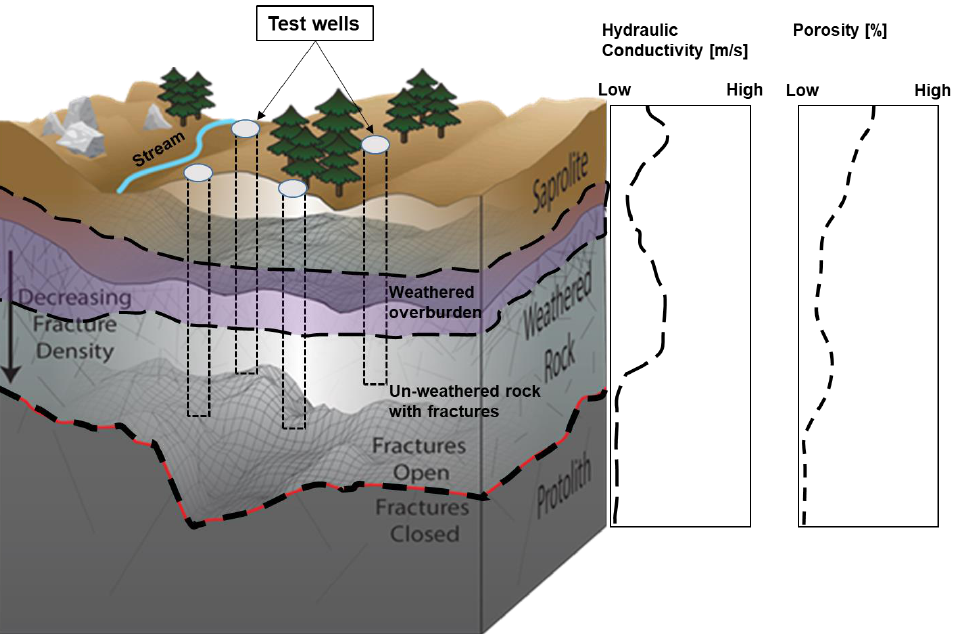
Figure 1. A conceptual model of crystalline basement aquifers and a qualitative hydraulic conductivity and porosity profile through their different layers (Adapted with permission from Flinchum et al. [19]. 2023, John Wiley and Sons.).